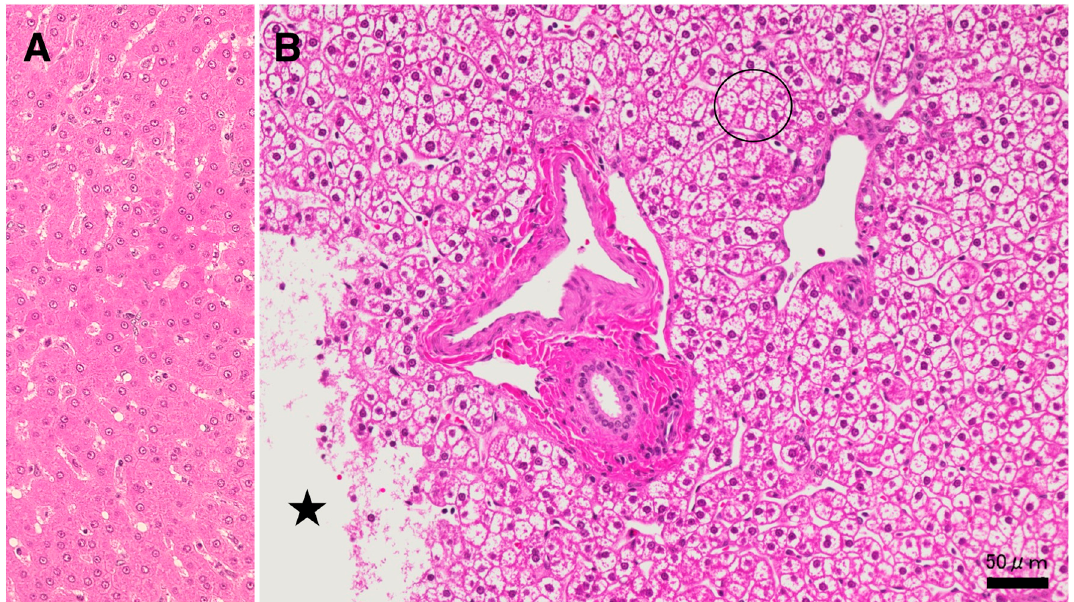
Figure 2. Histological findings from the hydroxynonenal-treated liver. In light microscopy, the whitish-yellow portion (Figure 1B, HNE) of the liver after the consecutive hydroxynonenal injections exhibited widespread fatty degeneration of hepatocytes and focal necrosis (( B ), star). The cytoplasm of the affected hepatocytes around the portal triad (( B ), circle) was translucent, presumably due to the dissolution of lipid components during ethanol dehydration. This was in marked contrast to the normal hepatocyte ( A ). Star: focal necrotic area, H-E staining.